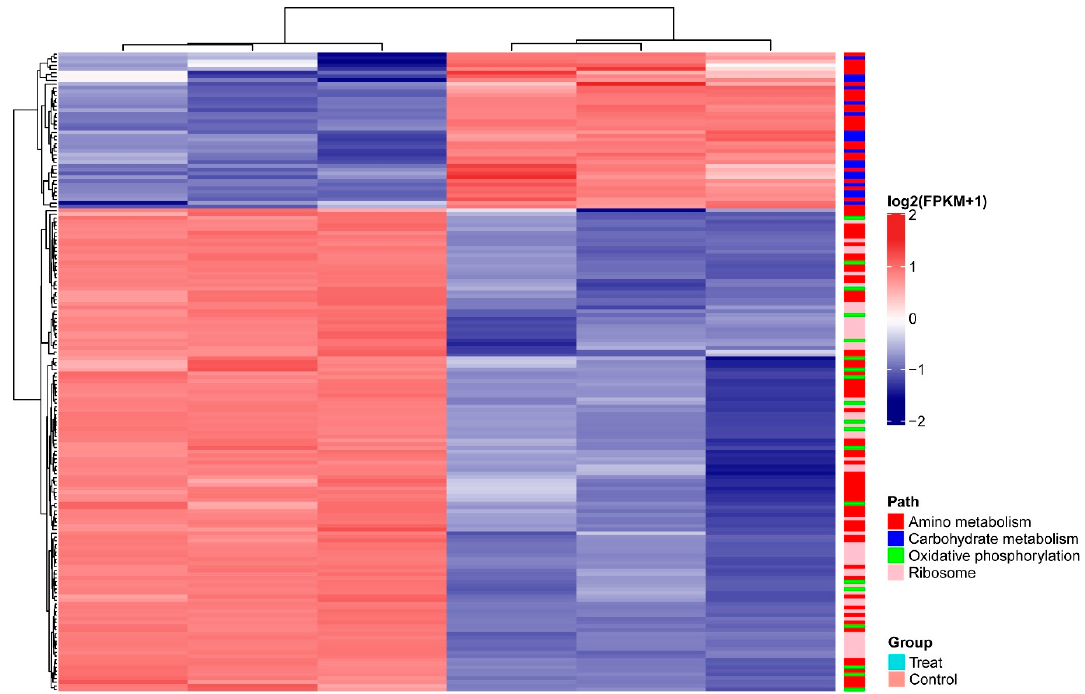
Figure 5. Heatmap of differentially expressed genes ( p < 0.05 and |log2(fold change)| > 1.5) involved in amino metabolism, carbohydrate metabolism, oxidative phosphorylation and ribosomes of A. pascens ZZ21. Expression values (FPKM) were log 2 transformed and normalized by Z-score. Genes that participate in different pathways are labeled with different colors to the right of the heatmap. A. pascens ZZ21 treated with C. elegans extracts was the experimental group (Treat), A. pascens ZZ21 without the treatment with C. elegans extracts was the control group (Control).